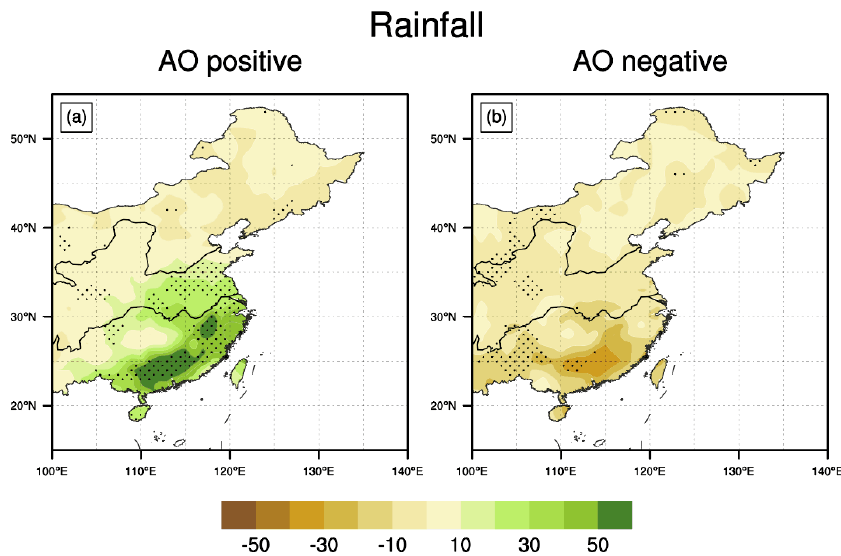
Figure 10. Precipitation anomaly fields in winter for the ( a ) positive AO and ( b ) negative AO (unit: mm). Dots represent the values above the 90% confidence level.